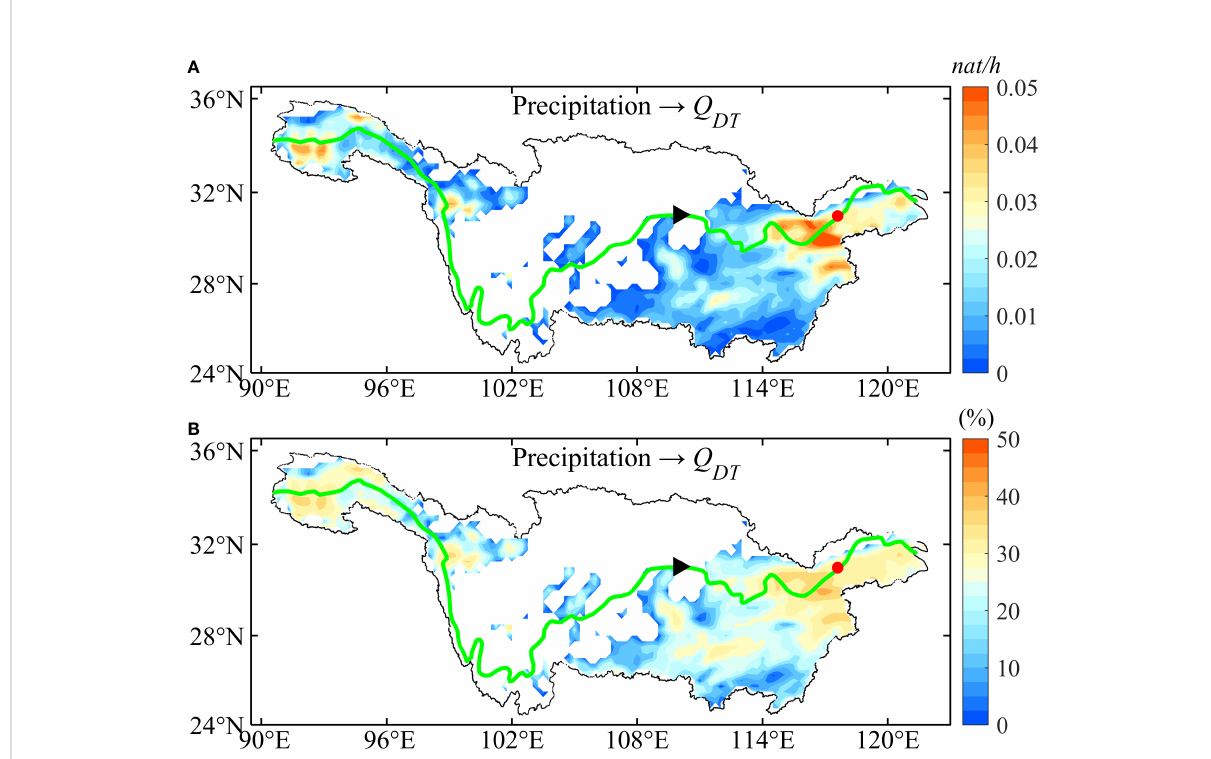
FIGURE 9 Distributions of results of the one-way causality analysis in the Yangtze River Basin. (A) Rate of information fl ow ( IF ) from precipitation to discharge at the DT station ( Q DT ); (B) Relative IF from precipitation to discharge at the DT station ( Q DT ). Since the precipitation data is of hourly interval, the hourly Q DT was picked up to match the time of precipitation data. Only positive values are presented in the fi gure, while the non- positive values are masked by